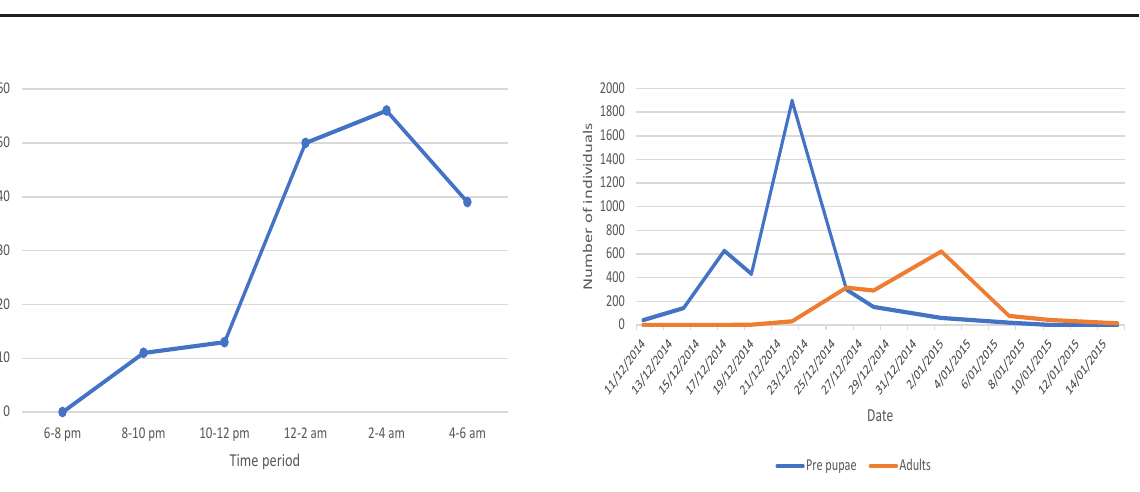
Figure 5. Number of Prodiplosis longfila Gagné pre-pupae collected on the ground and adults emerged per square meter.